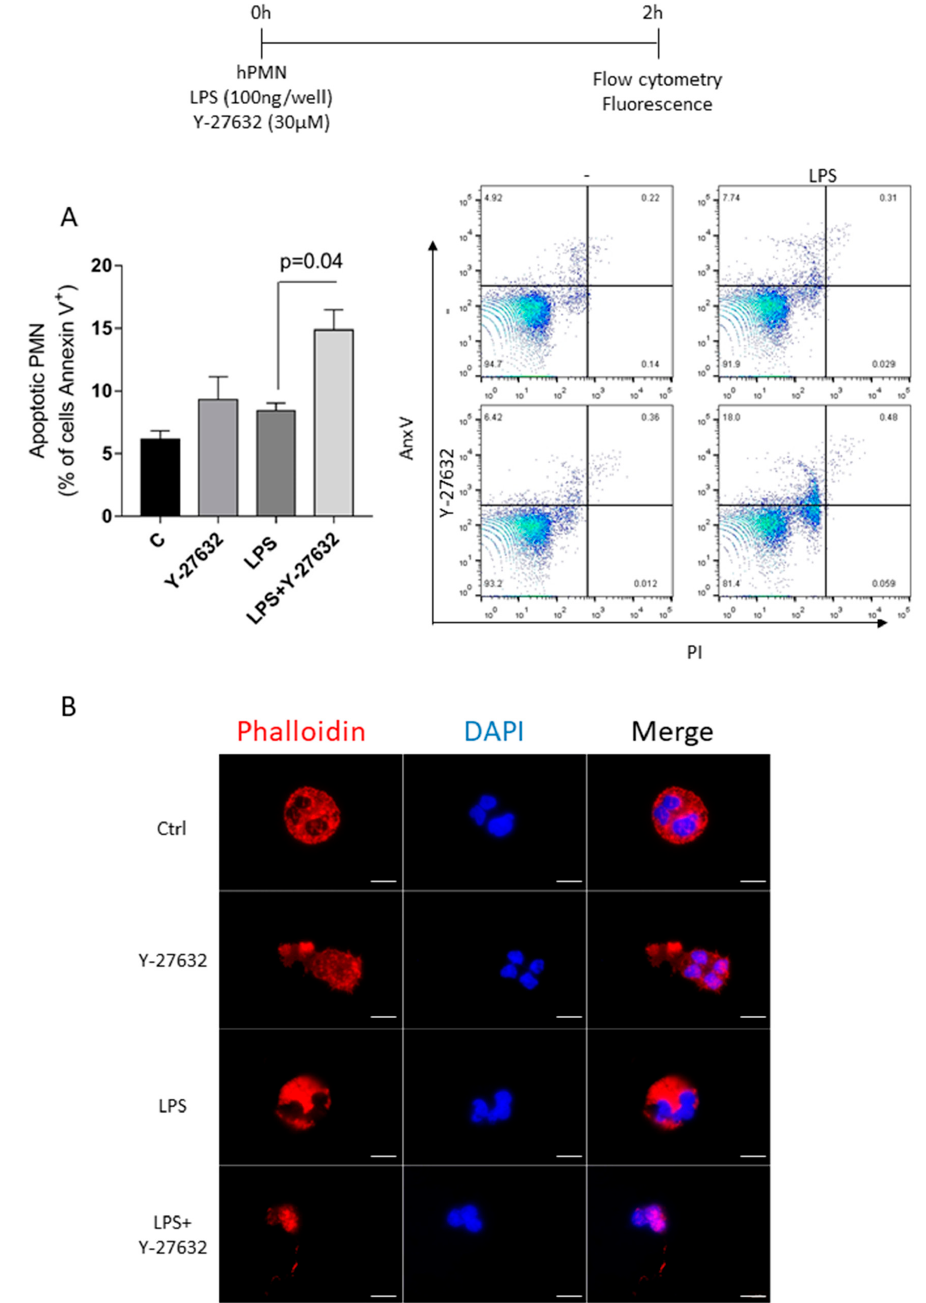
Figure 6. E ff ects of Y-27632 on human neutrophil apoptosis stimulated with LPS. Human peripheral blood samples were collected from healthy donors and isolated PMN were cultured for 2 h at 37 ◦ C with 5% CO2 with the vehicle (C), treatment (Y-27632), stimulus (LPS) and both (Y-27632 + LPS). Apoptosis was determined by flow cytometer and are expressed as percentage of annexin V + cells ( A